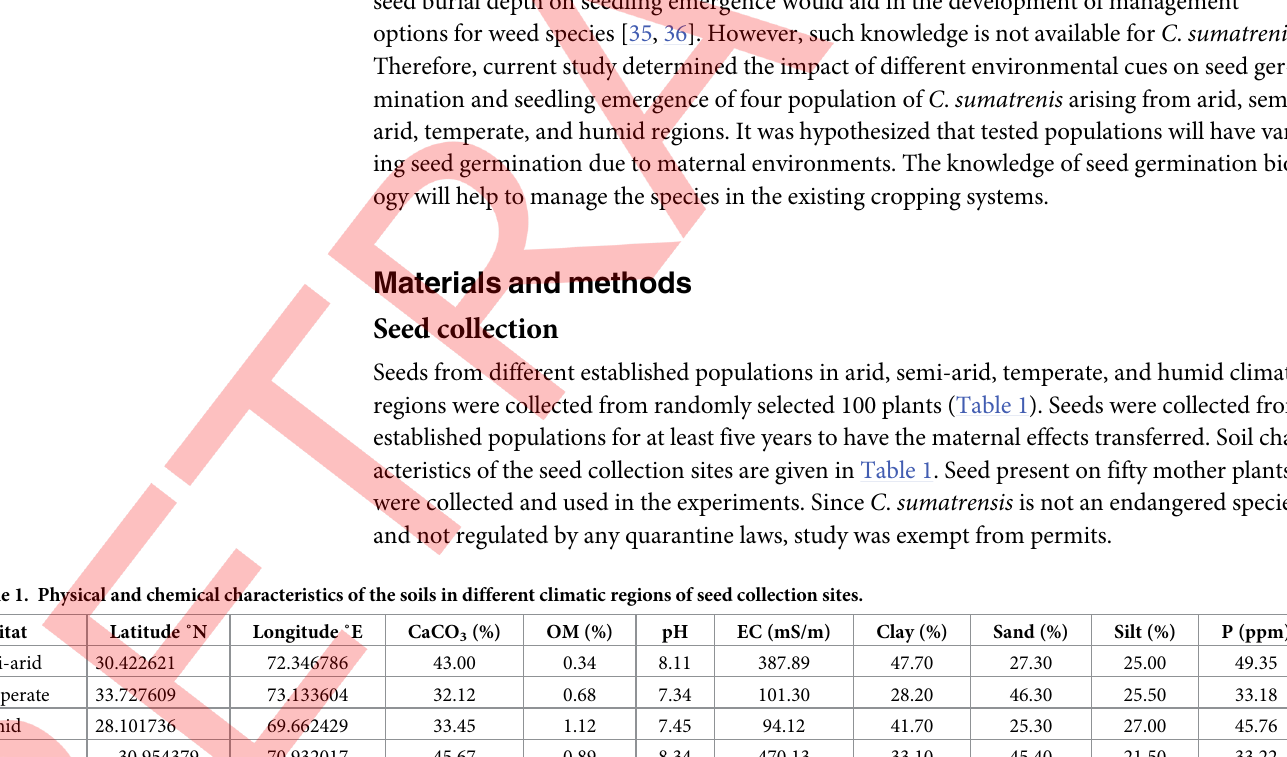
Table 1. Physical and chemical characteristics of the soils in different climatic regions of seed collection sites. Habitat Latitude ˚N Semi-arid Temperate Humid 28.101736 Arid OM = organic matter, P = phosphorus, EC = electrical